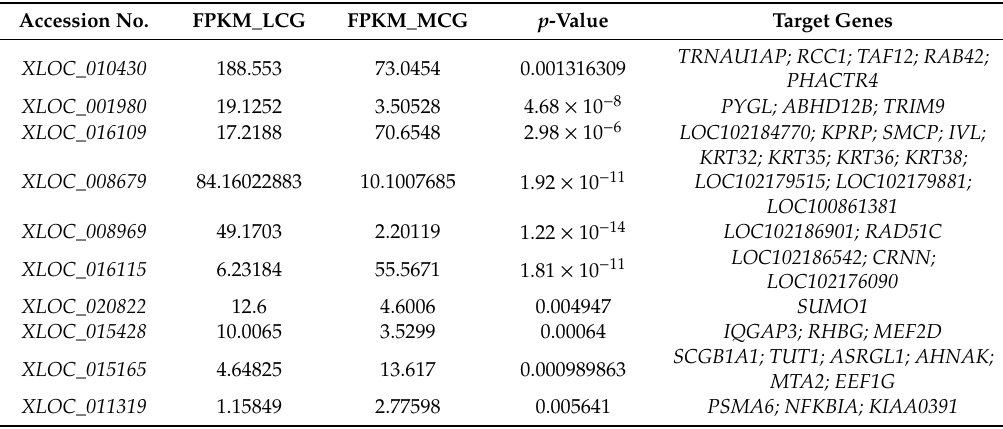
Figure 3. Volcano plot of differentially expressed genes in Liaoning cashmere goats (LCG) and Mongolia cashmere goats (MCG). Table 2. Differentially expressed lncRNAs with target genes in LCG and MCG.